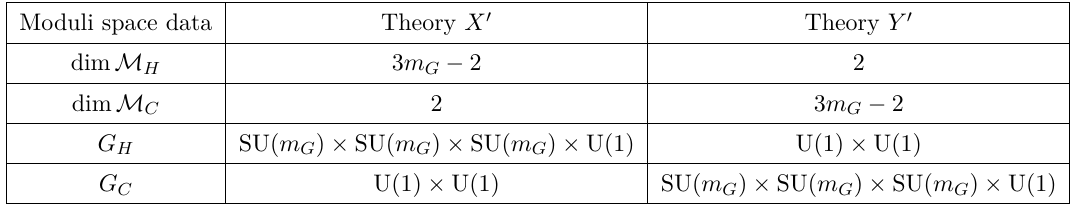
Table 1 . Summary table for the moduli space dimensions and global symmetries for the mirror pair in figure